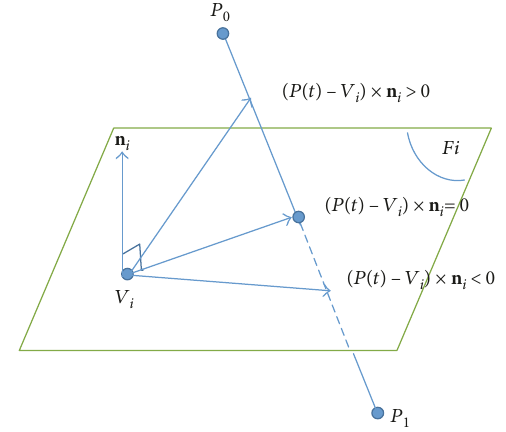
Figure 4: Intersection of a line segment to a convex facet in 3-D.